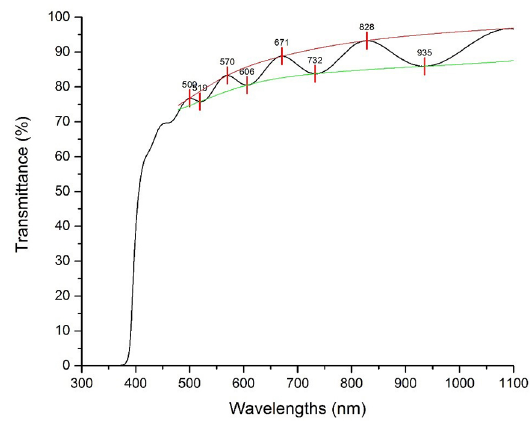
Figure 9. Optical transmittance spectra for undoped zinc oxide compared to ZnO/Ag bilayers deposited with different Ag thicknesses